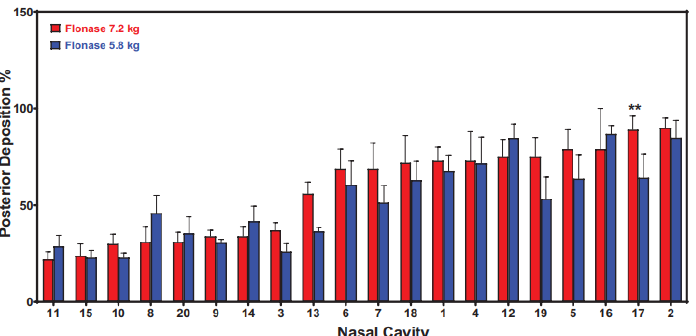
Figure 3. Posterior deposition in 20 nasal models sorted in ascending order. Two actuation forces were utilized. ** indicates significant difference in one model between the 5.8 and 7.2 kg actuation forces [8].